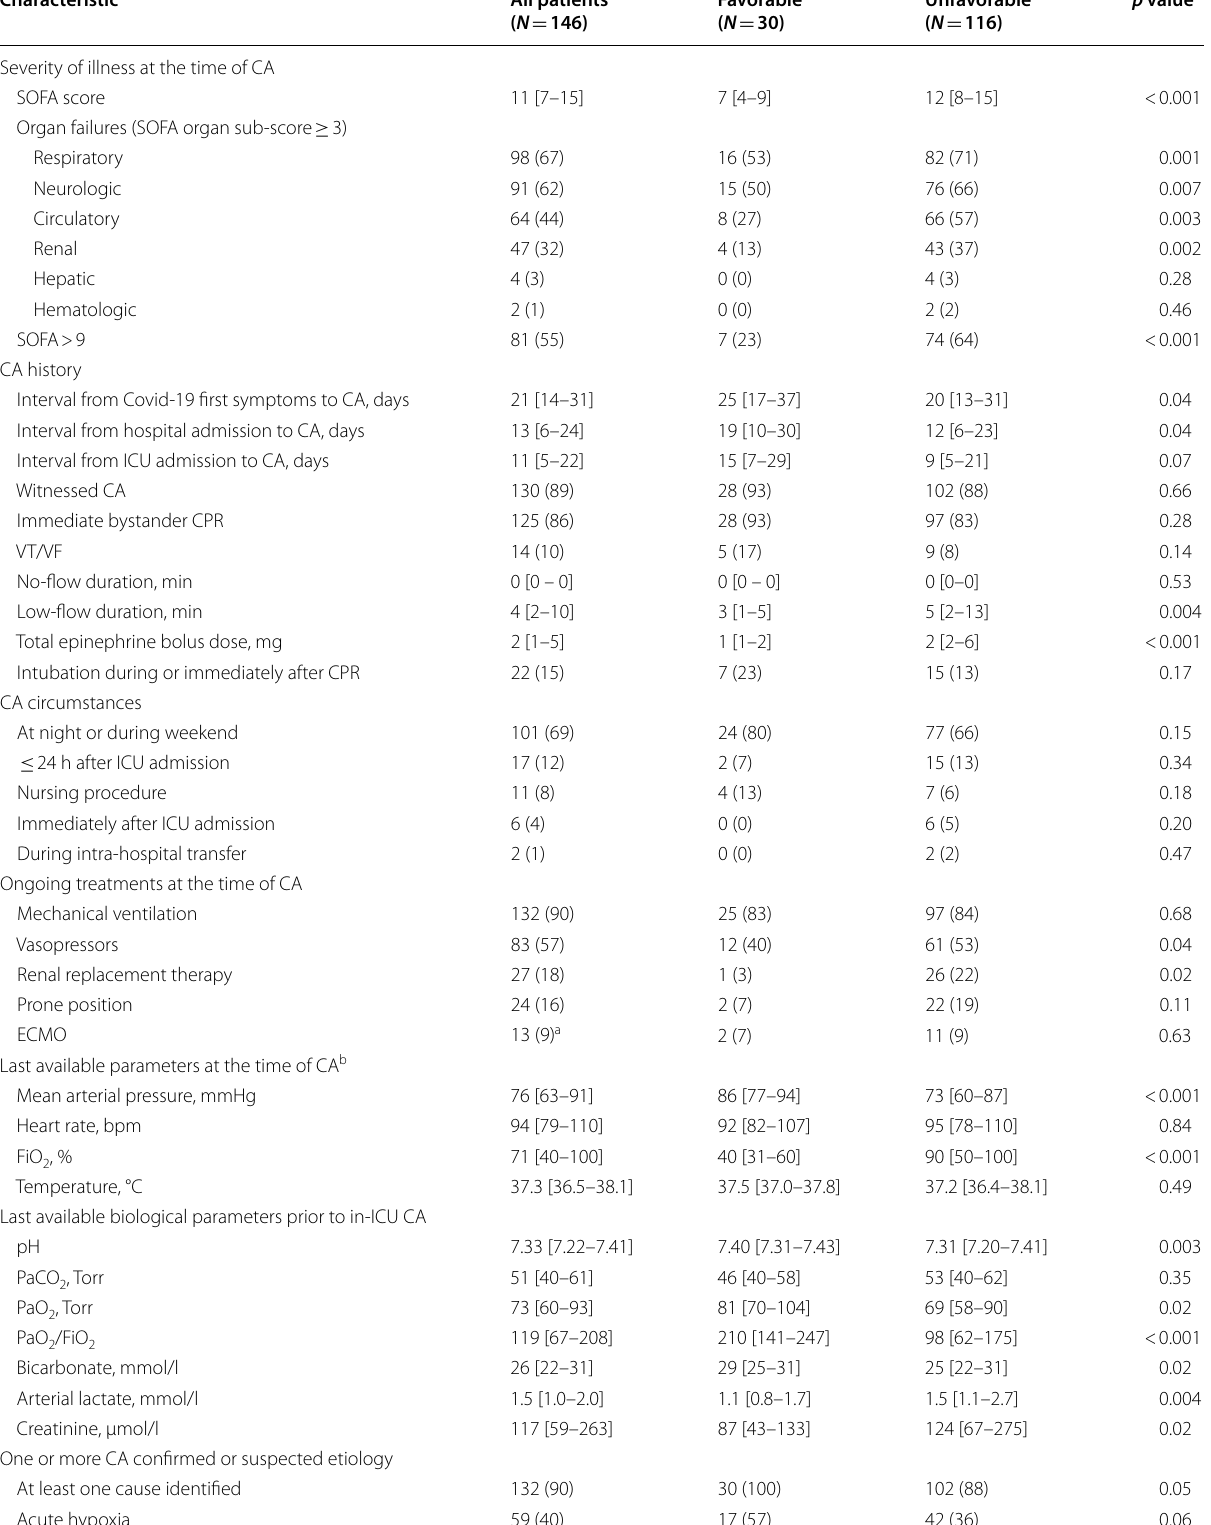
Table 2 Main patients’ characteristics at in‑ICU cardiac arrest occurrence according to outcome at day